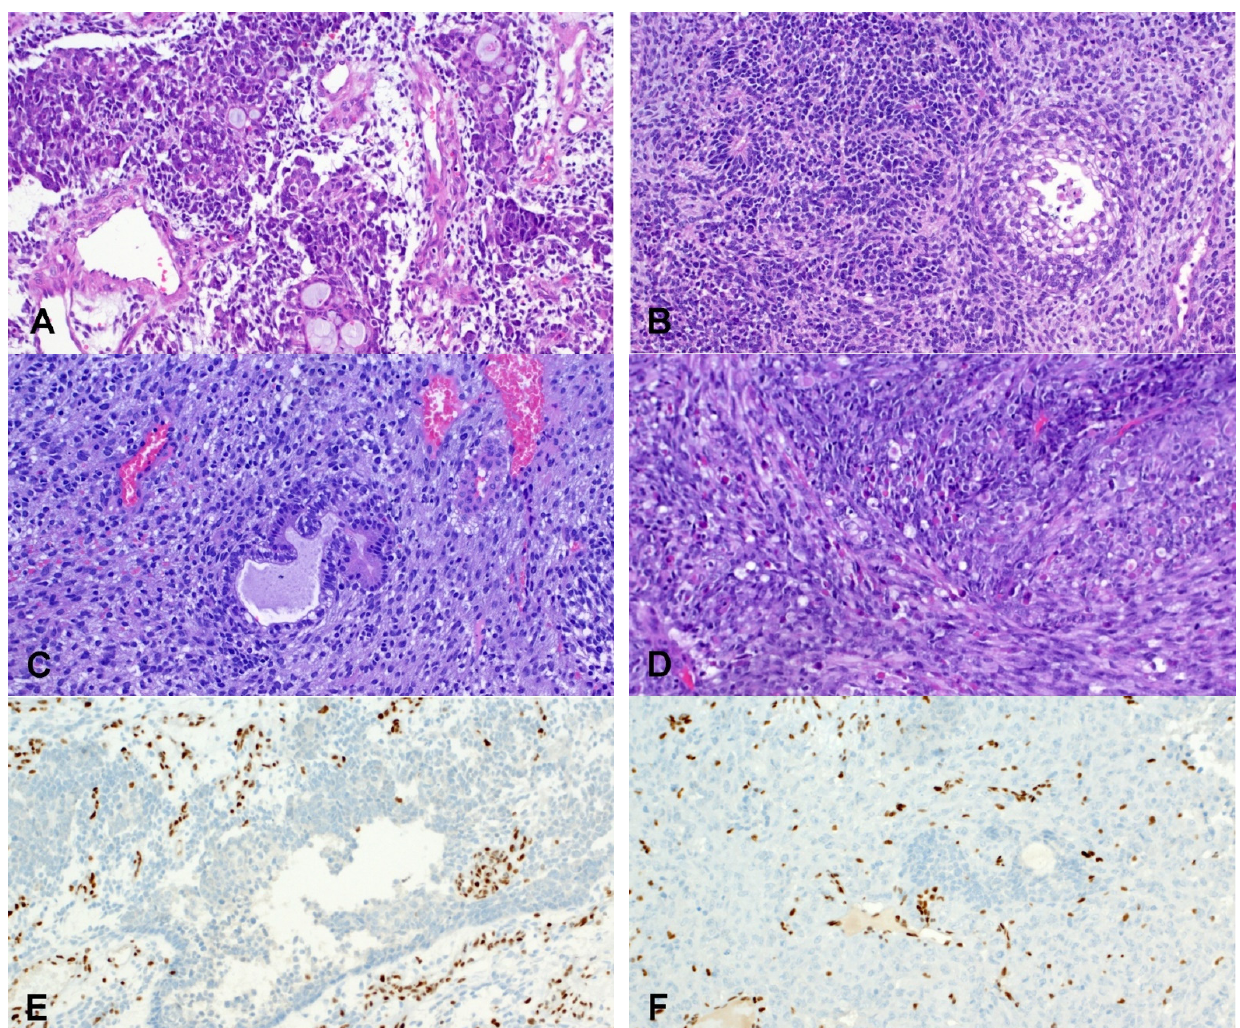
Figure 5. Examples of sinonasal teratocarcinosarcoma showing the triphasic pattern. The epithelial component varies from disordered mucous glands ( A ) to primitive clear cell fetal-type squamous ( B ) or tubular ( C ) structures (Hematoxylin and eosin, 10× Objective original magnification). The stroma varies from primitive neuroectodermal-type ( B ) to lose spindled or primitive non-descript ( C) . Variable rhabdomyoblastic differentiation is frequent ( D ). Global loss of SMARCA4 in the epithelial ( E ) and the primitive and mesenchymal stroma ( F ).